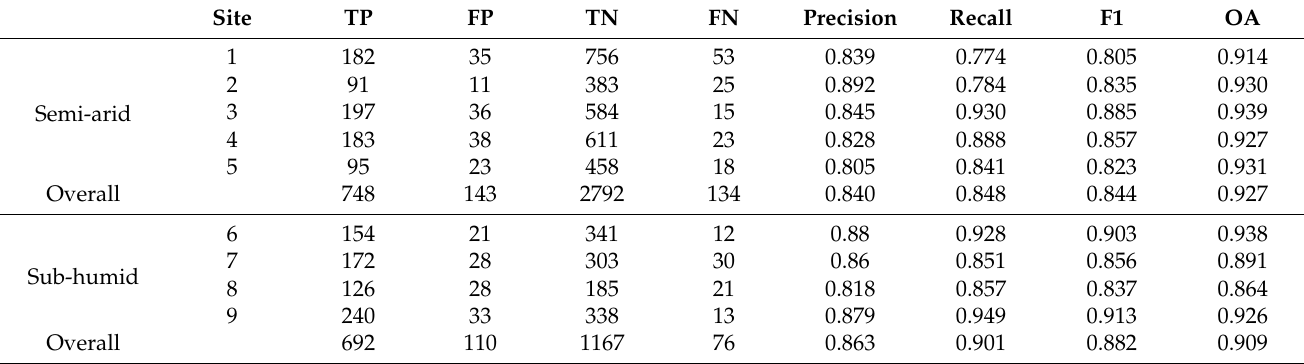
Table 5. Evaluation metrics for olive orchard mapping using region sampling with DG imagery (1st evaluation).